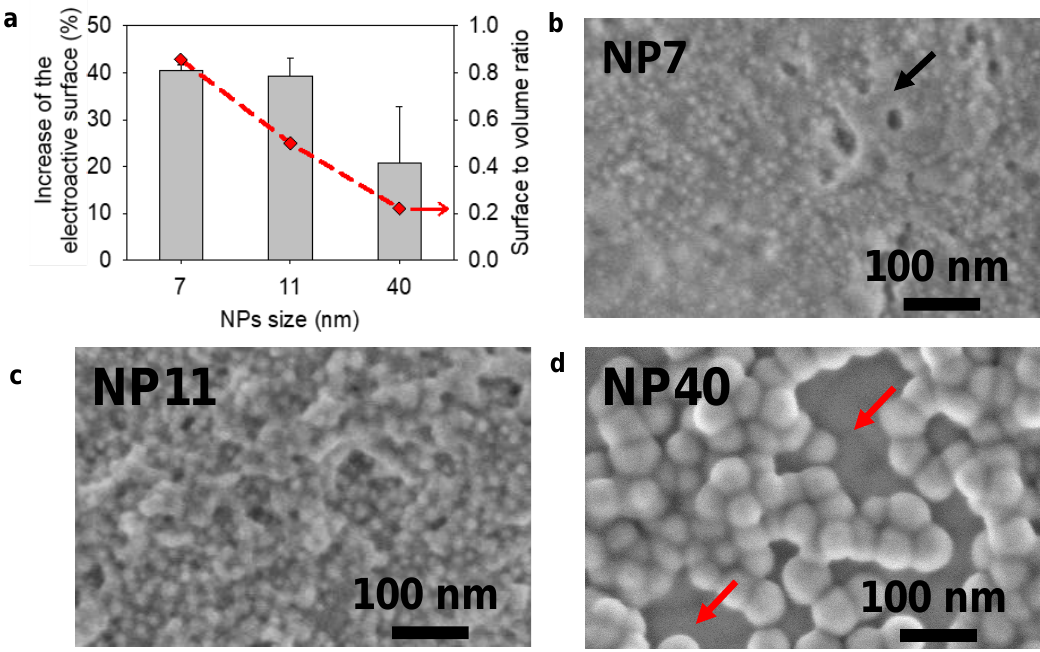
Figure 4. Electrodeposition of NPs with different sizes: ( a ) relative increase of the electroactive surface area (EASA) and surface to volume ratio of NPs (red diamond) as a function of NP size; SEM micrographs of the obtained coatings using ( b ) NP7, ( c ) NP11 and ( d ) NP40. Red arrows indicate the presence of an uncoated area where the underlying electrode is visible and the black arrow the presence of an organic area.